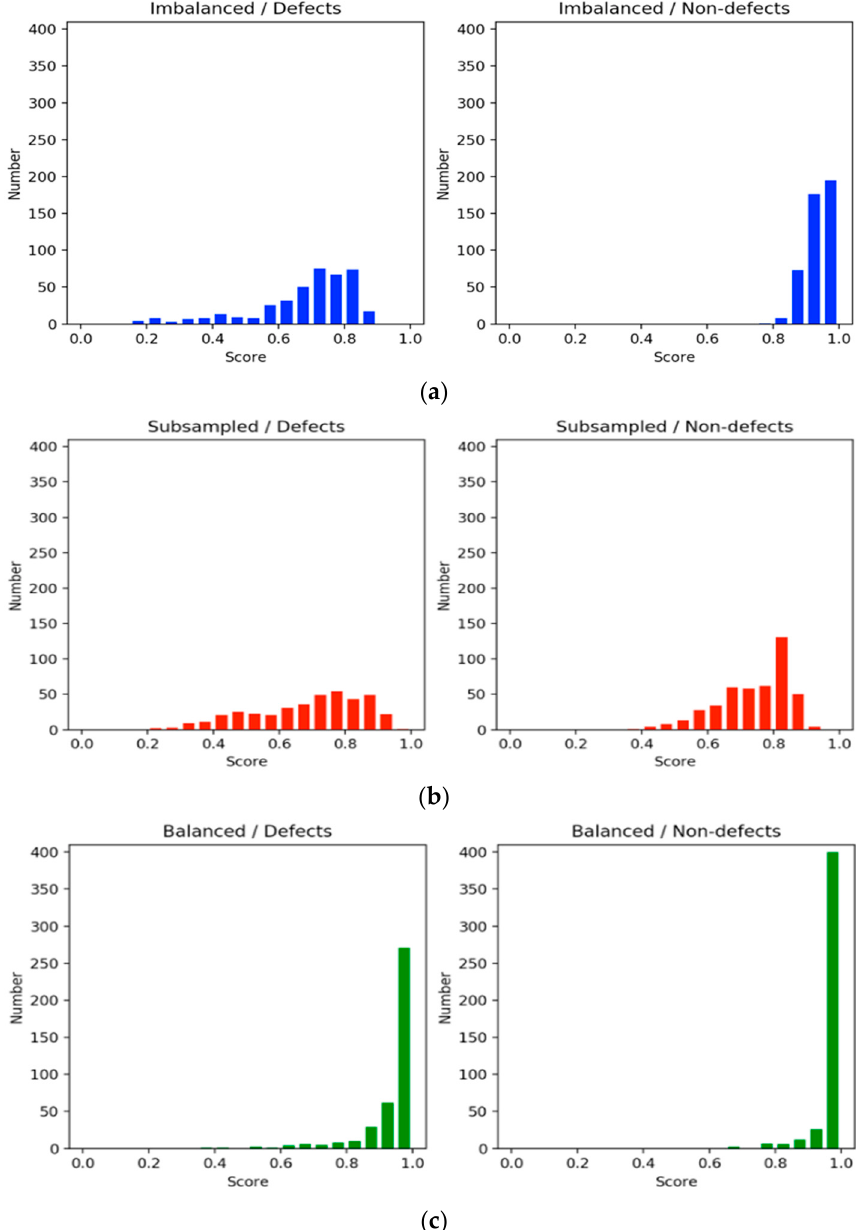
Figure 6. Comparison of the histograms of the scores of various methods. ( a ) Imbalanced, ( b ) sub- sampled, and ( c ) balanced.